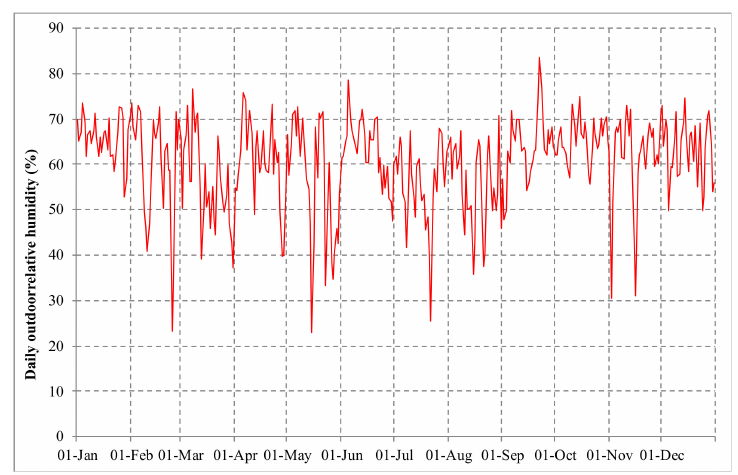
Figure 3. Trend of the outdoor air relative humidity during the monitoring period.